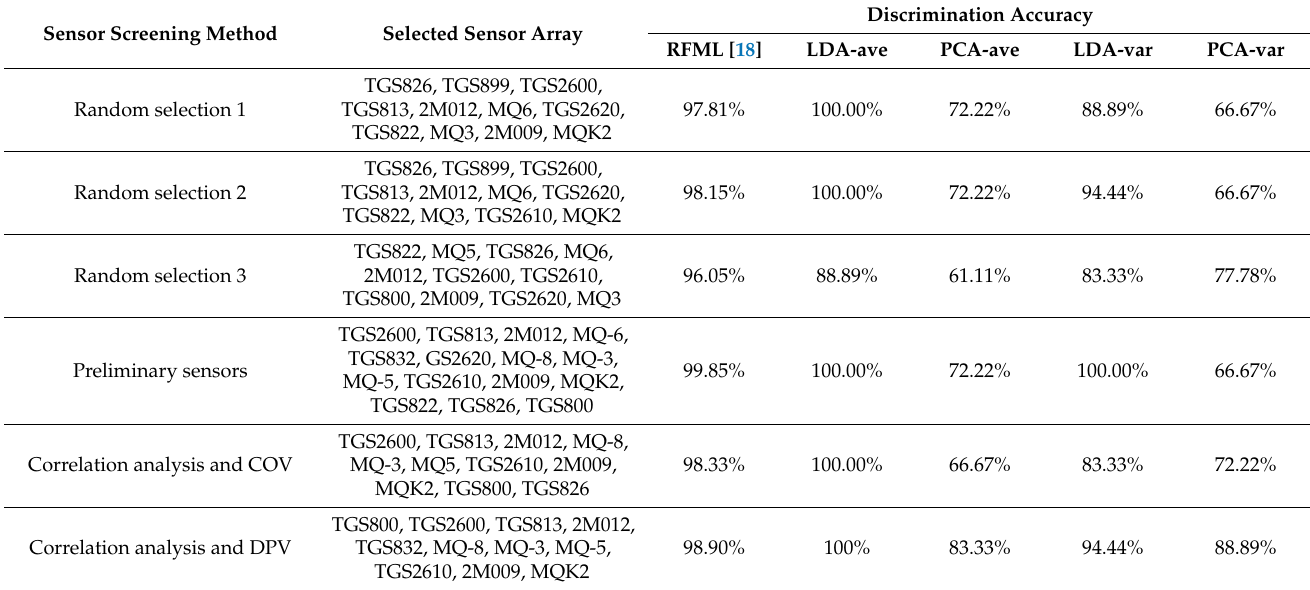
Table 12. Discrimination accuracy of the sensors screened by different methods at the first step.